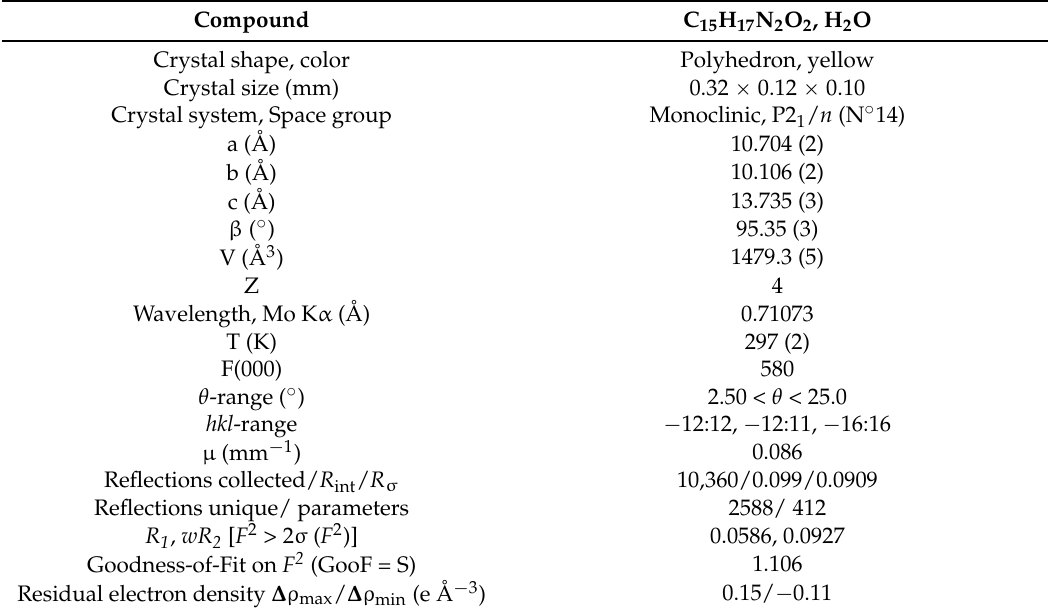
Table 3. Crystal data and details of the structure determination.